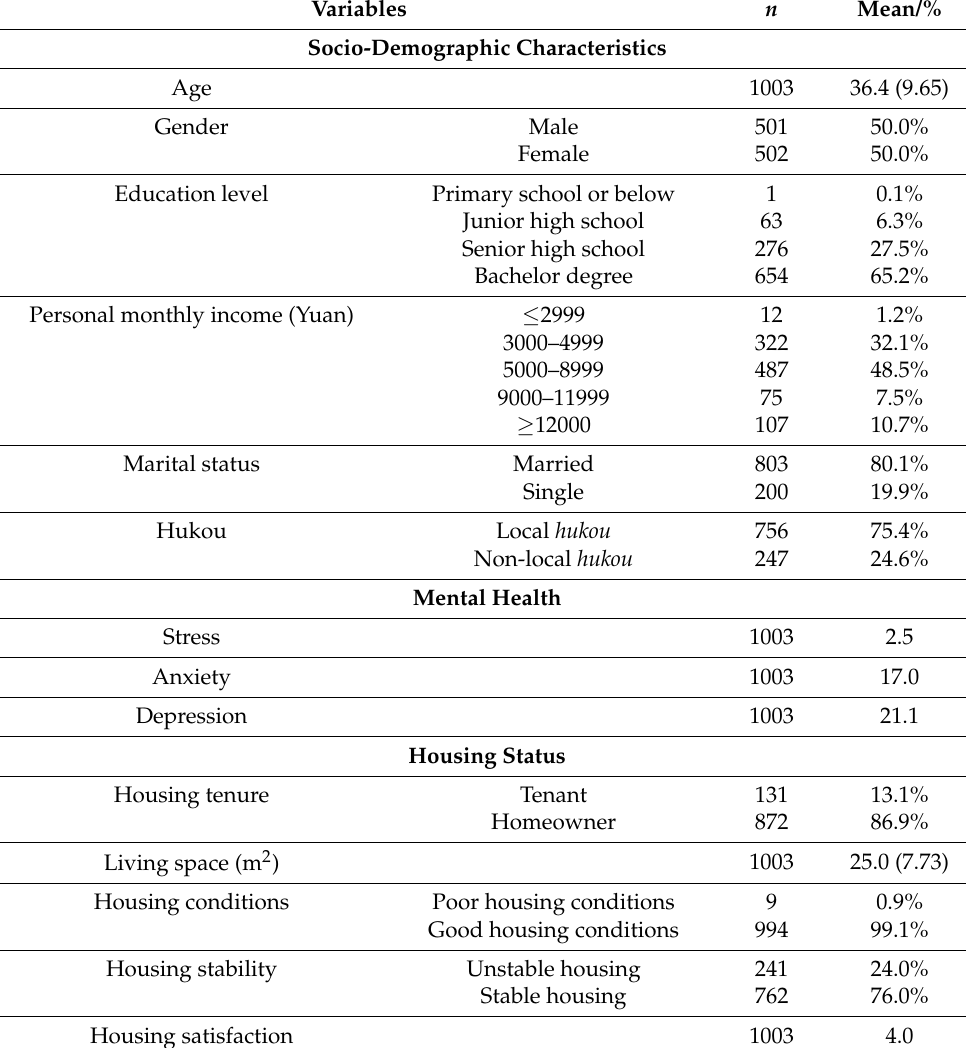
Table 1. Descriptive statistics of all variables (n =